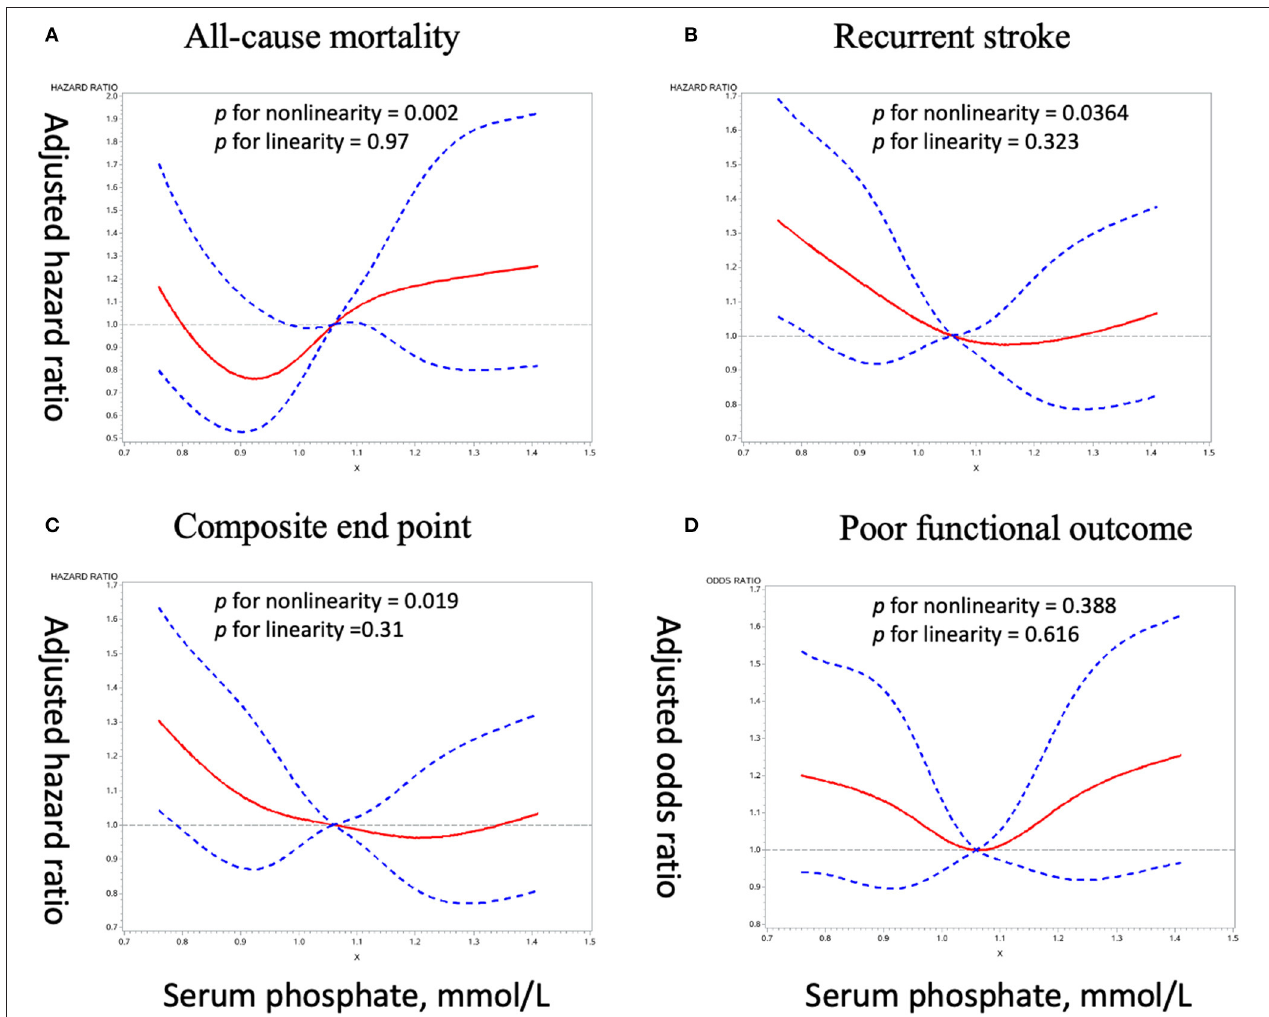
FIGURE 2 | Adjusted dose–response association between serum phosphate levels and adverse clinical outcomes. (A) , All-cause mortality. (B) , Recurrent stroke. (C) , Composite end point. (D) , Poor functional outcome.